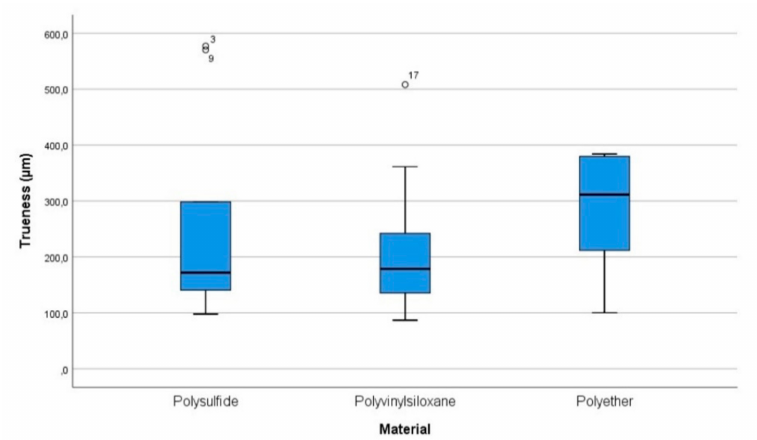
Figure 6. Box plot chart of trueness values. The central rectangle spans the first quartile to the third quartile and whiskers above and below the box show the locations of the minimum and maximum. The segments inside the rectangle shows the median, and unfilled circles represent suspected outliers.